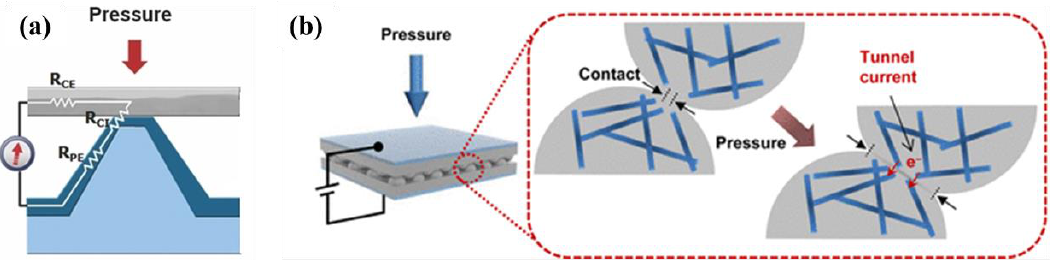
Figure 4. ( a ) Circuit model used to derive the sensing principle of the sensor, which relies on the change of the microstructure in response to pressure [39]. ( b ) The external pressure concentrates stress at the contact spots, which in turn causes an increase in the contact area and the tunneling currents [41].